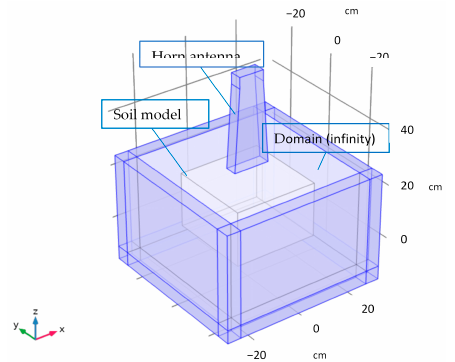
Figure 1. Construction of the microwave simulation model.